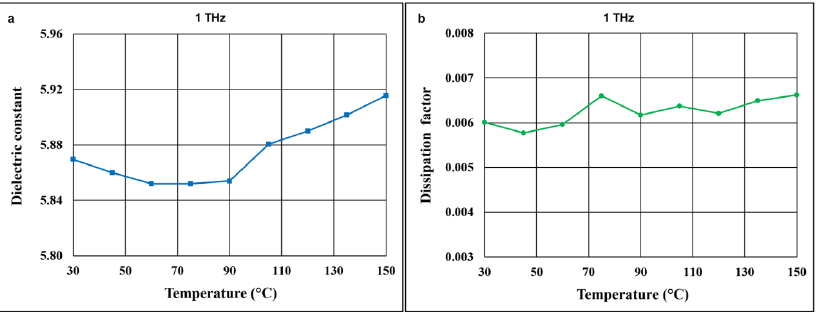
Figure 13. Dielectric constant ( a ) and dissipation factor ( b ) at 1 THz versus temperature in the 30–150 °C range for 87% Zn 4 B 6 O 13 –13% Zn 2 SiO 4 ceramic sintered at 930 °C.